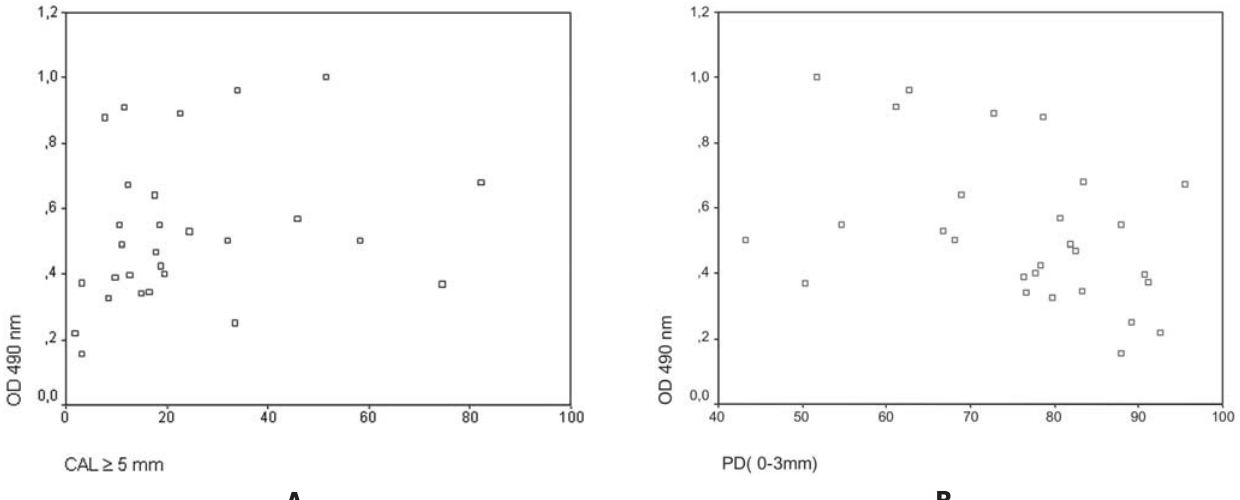
values after ELISA for IgG antibodies against P. gingivalis 490 =+ 0.375, p<0.05). B - Scatter plot showing the correlation s